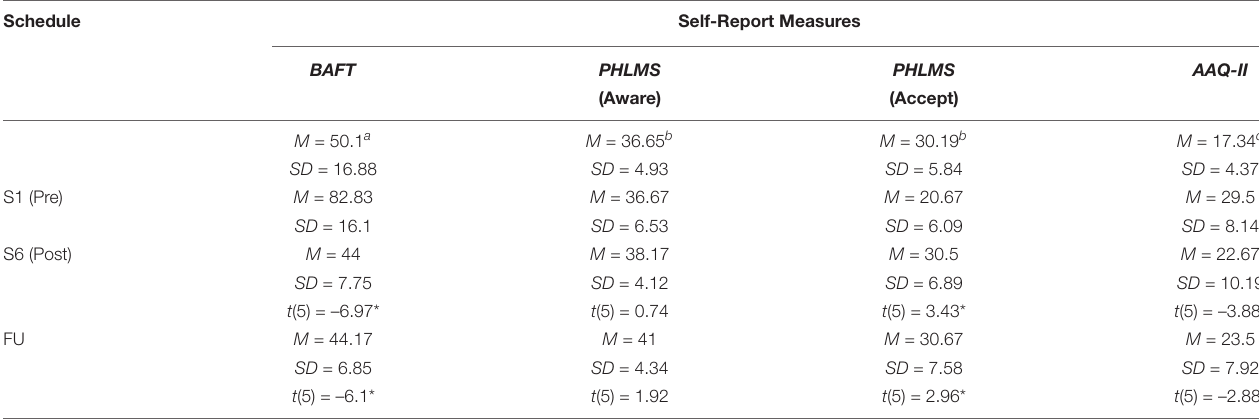
TABLE 1 | Descriptive data and mean scores for ACC-based measures, as well as results of paired t -tests comparing pre-coaching means (Session 1) to means at post-coaching (Session 6) and at a 3-month follow-up. Schedule